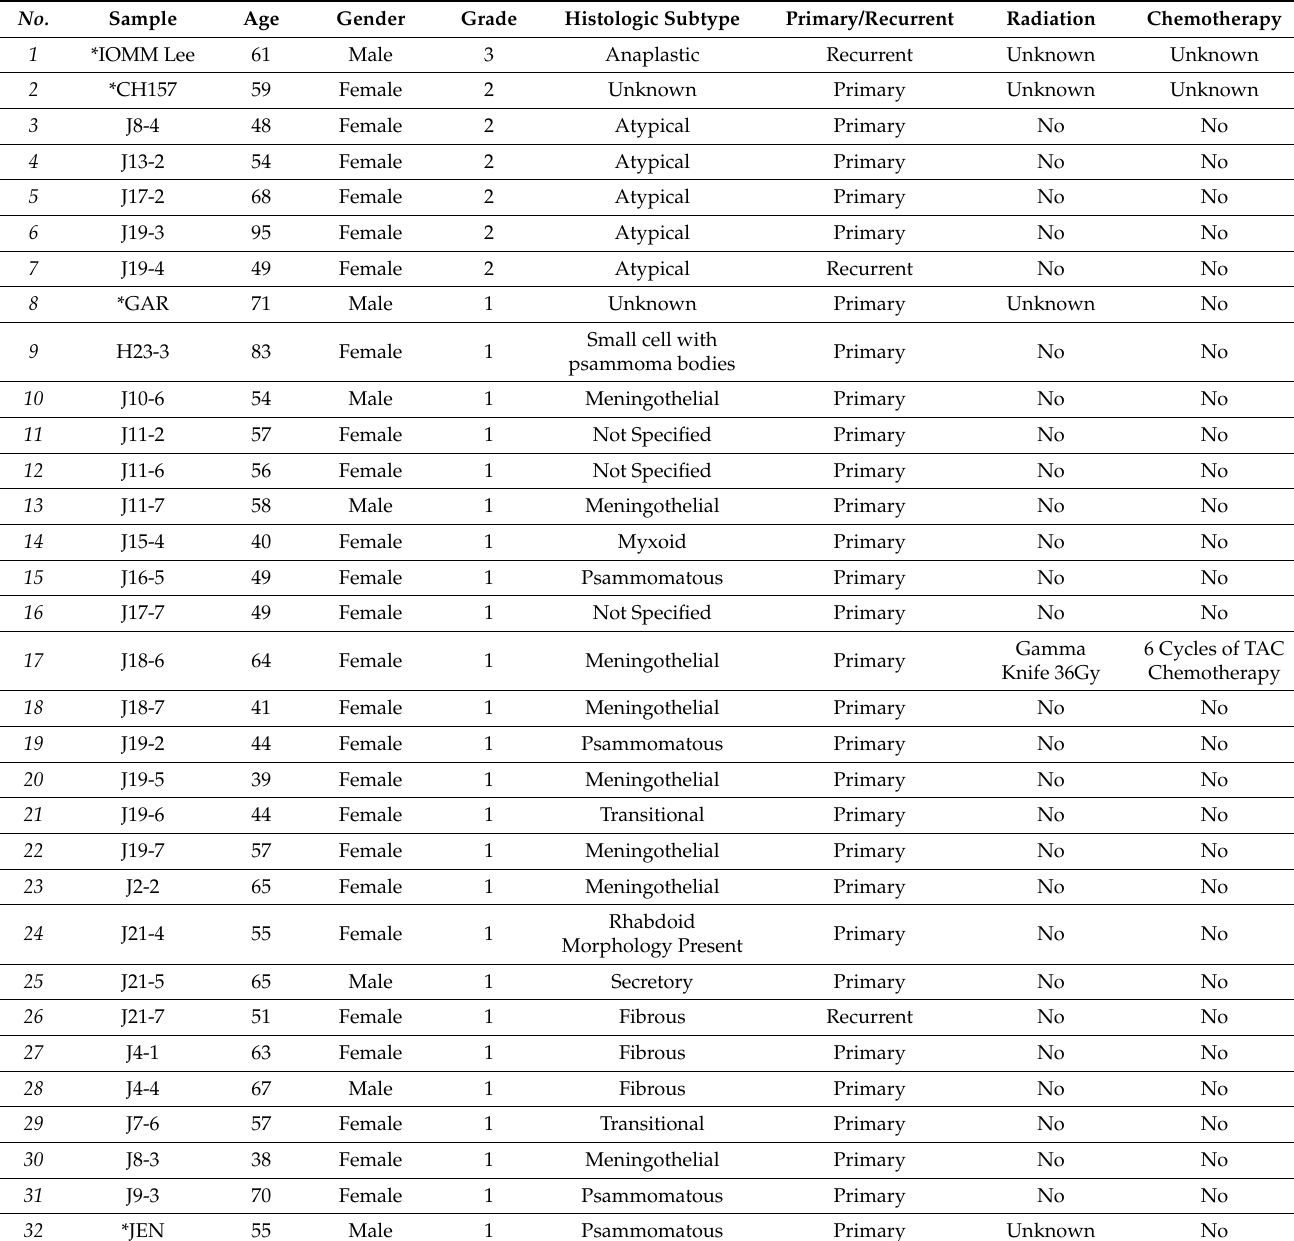
Table 1. Patient demographics for the meningioma